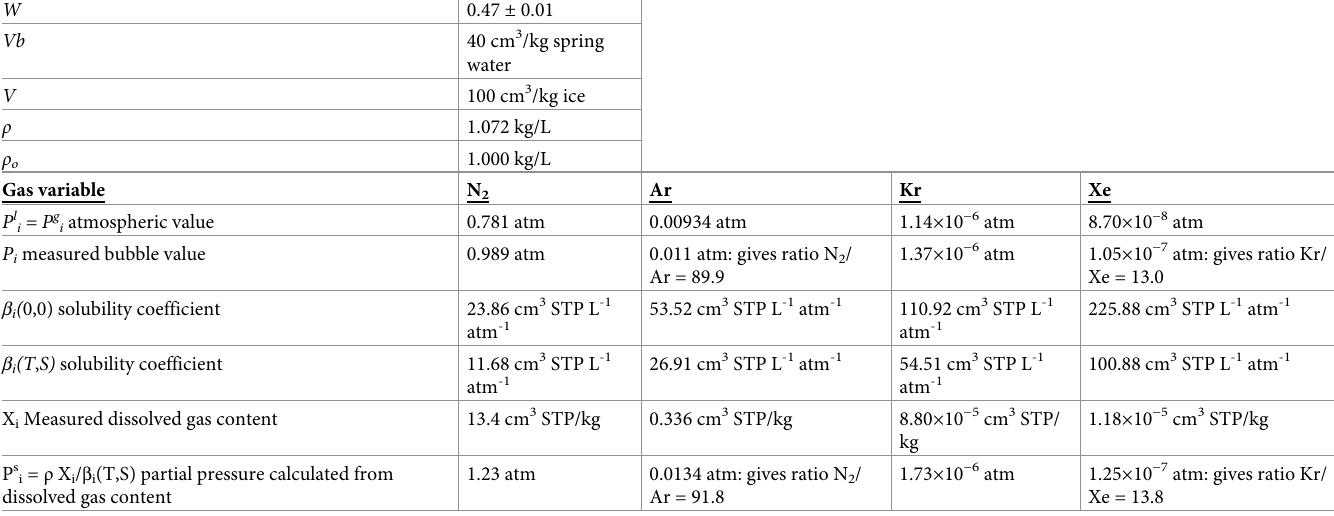
cm 3 STP/atm per liter water) which is defined as the volume of gas measured at STP that is Table 3. Listing of the numerical values used in, or obtained from, the solution of Eq 4. W 0.47 ±